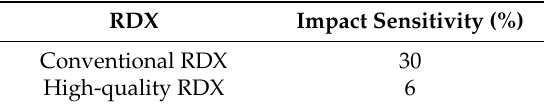
Table 7. The impact sensitivity of RDX.